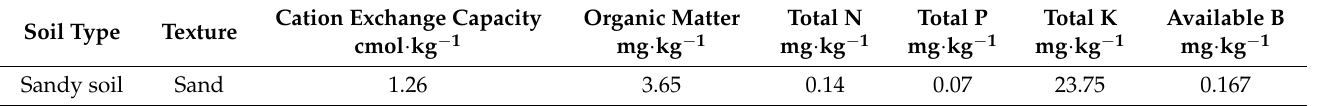
Table 1. Basic properties of the trail